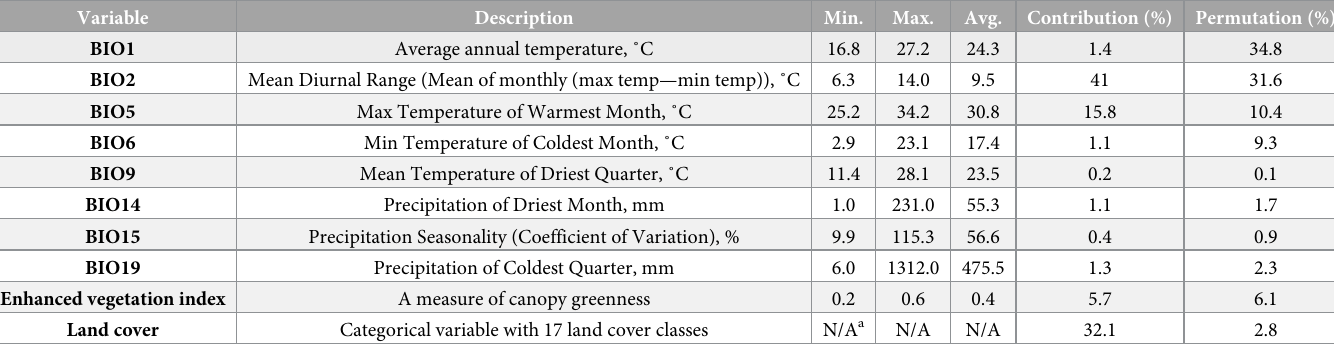
Table 2. Minimum, maximum, average values, percent contribution, and permutation importance of variables in the Hg . janthinomys model.